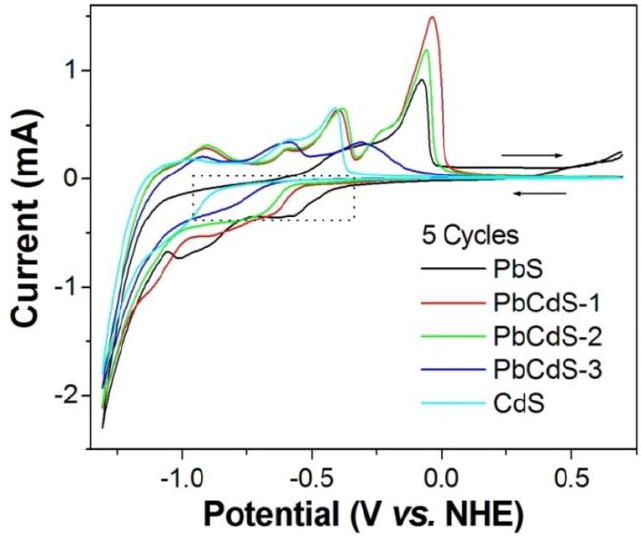
Figure 3. Cyclic voltammograms (CVs) of five-SILAR-cycle PbS, PbCdS-1, -2, -3, and CdS-sensitized TiO 2 electrode. CVs were measured with the electrolyte of 0.1 M KCl in deionized water (pH 6.9), and the scan rate was 10 mV/s. The arrows indicate the scan direction. The dotted part in the CV figures is to show the onset potentials of the reduction current varied at the different electrodes.